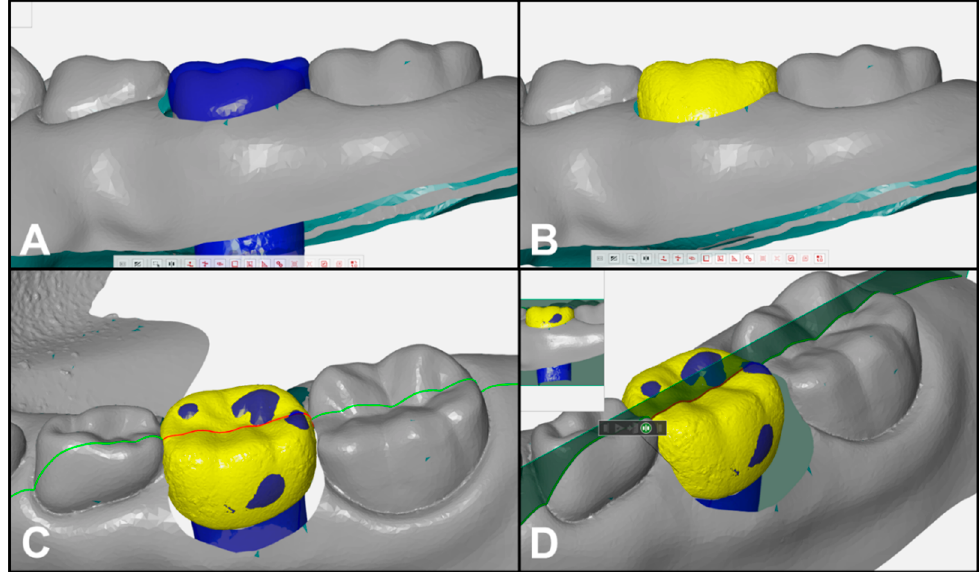
Figure 2. Digitally reconstructed models: (A) model A; (B–D) digital setup of PZC of the left mandibular primary second molar (Model B). The PZC was digitally aligned considering the marginal ridge level of the adjacent teeth and occlusion.